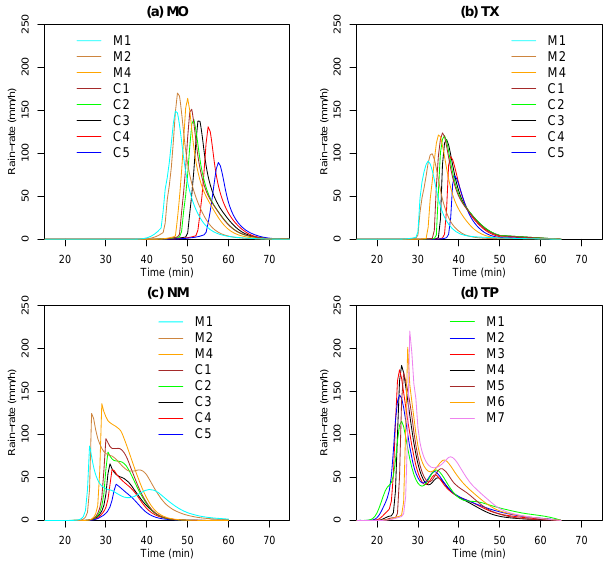
Fig. 4. Temporal evolution of precipitation intensity at cloud centre for (a) MO-v2, (b) TX-v2, (c) NM-v2 and (d) TP-v2. Time t = 0 refers to the start of simulation.